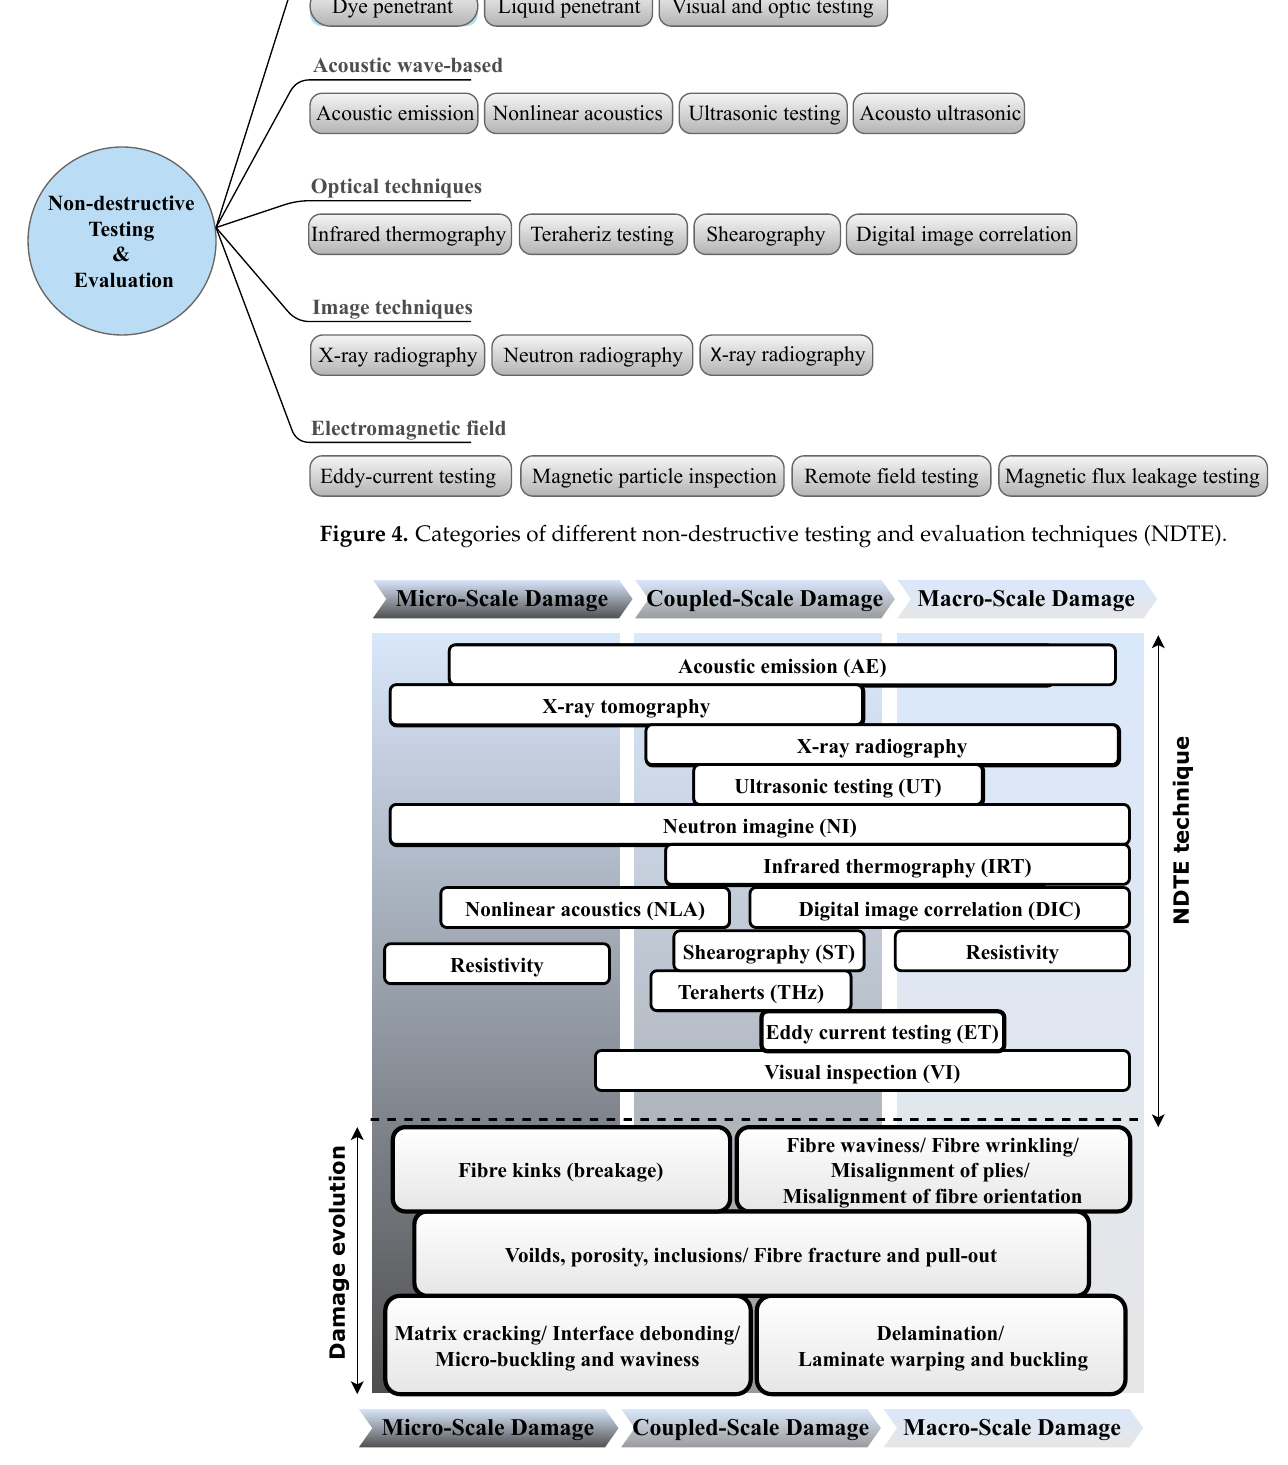
Figure 5. The range of damage to which different types of NDTE techniques can be